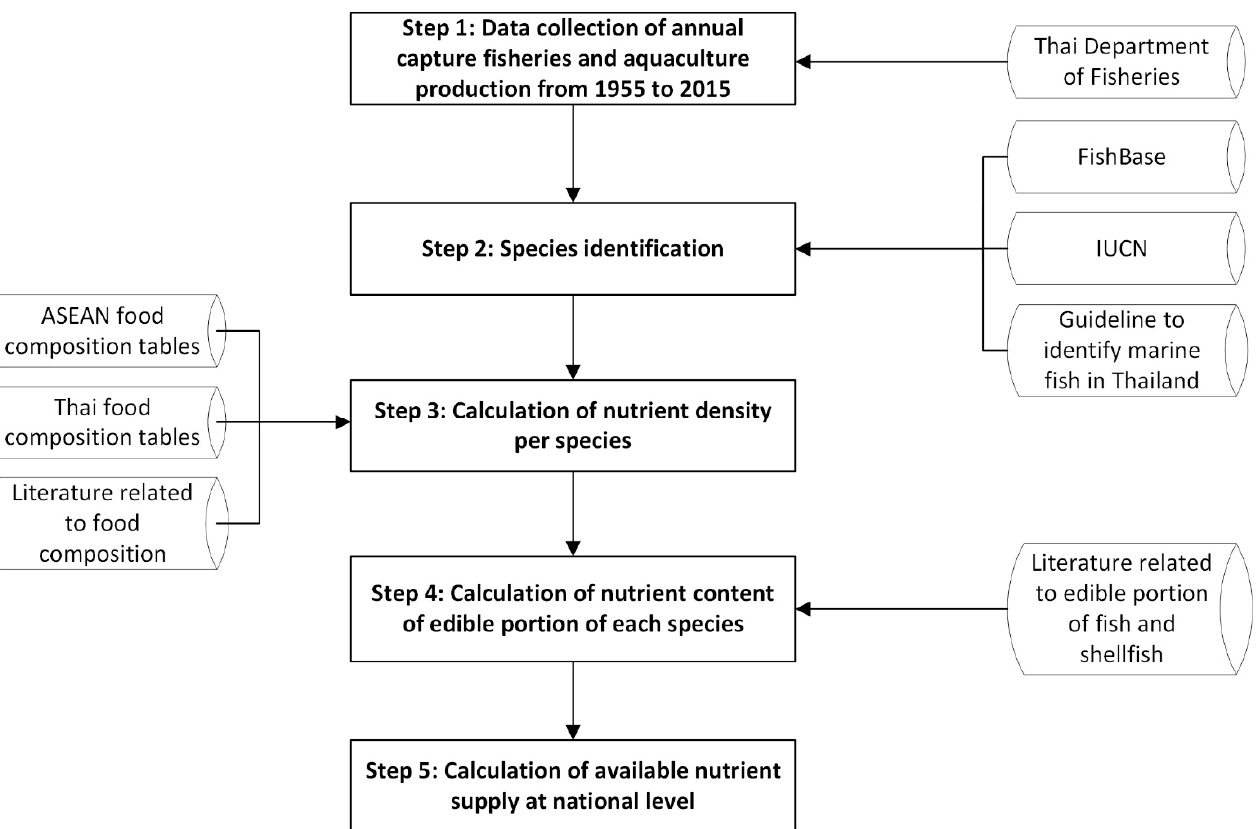
Figure 1. Flow chart of the data collection procedure and estimation of nutrient supplies.